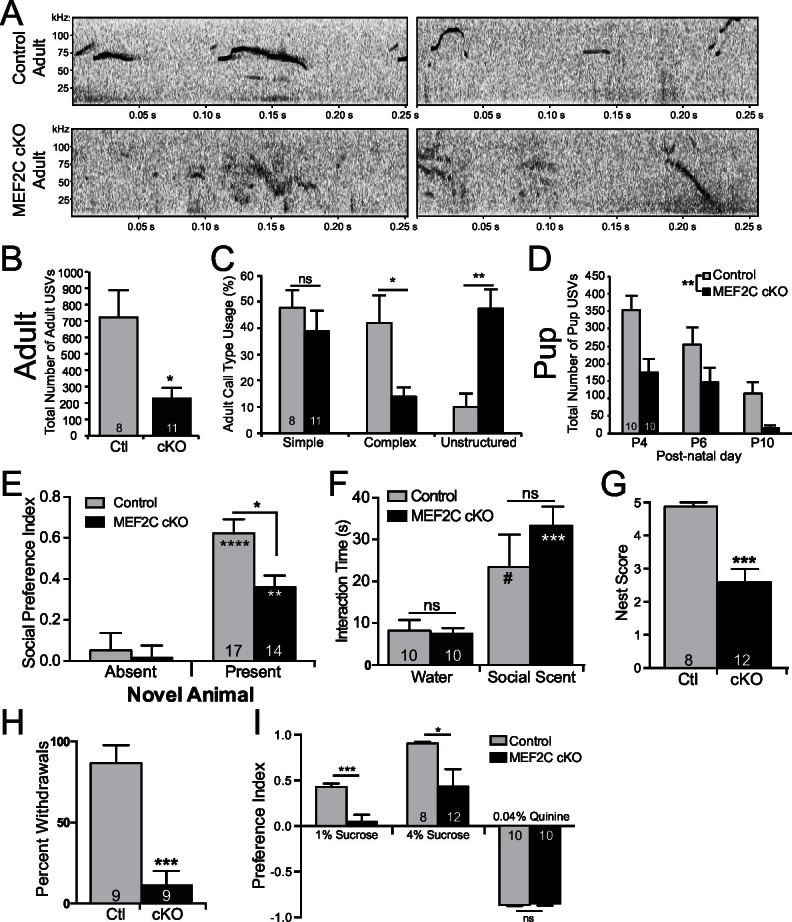
Social behavior abnormalities in Mef2c cKO mice.(A) Representative spectrograms of ultrasonic vocalizations (USVs) recorded from adult male mice in the presence of an estrous female mouse. (B) Adult Mef2c cKO male mice emit fewer USVs to an estrous female than control littermates. (C) Adult Mef2c cKO male mice show different call types than control littermates. Mef2c cKO mice have more unstructured USVs (%) and fewer complex USVs than control mice. Representative images of call types and further breakdown of USV sub-type are presented in Figure 5—figure supplement 1A,B. (D) Juvenile Mef2c cKO mice (pups) emit fewer USVs during maternal separation than control littermates. USVs were recorded on postnatal days (P) 4, 6, and 10. (E) Mef2c cKO mice show reduced preference for interacting with a novel social target. (F) Mef2c cKO mice show normal olfactory response to novel social scent. (G) Mef2c cKO mice fail to build structured nest when utilizing a nest score system (Deacon, 2006). (H) Mef2c cKO mice induce control littermates to withdrawal in the tube test for social dominance in >90% of trials. (I) Mef2c cKO mice show reduced preference for a natural reward, sucrose. Both genotypes showed aversion to the bitter solution, 0.04% quinine. Data are represented as mean ± SEM. Statistical significance was determined by unpaired t-test (B,G,H–I) or 2-way ANOVA with Sidak’s post-hoc comparison (C–F). #p<0.1, *p<0.05, **p<0.005, ***p<0.0005, ns=not significant. Numbers of animals (n) are reported in each bar for respective experiment. Also see Figure 5—figure supplement 1.